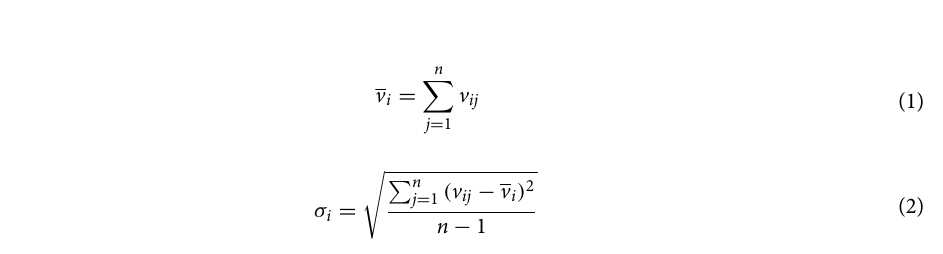
Table 4. Basic wind speed of each station in the Beijing–Tianjin–Hebei region at different reoccurrence periods.